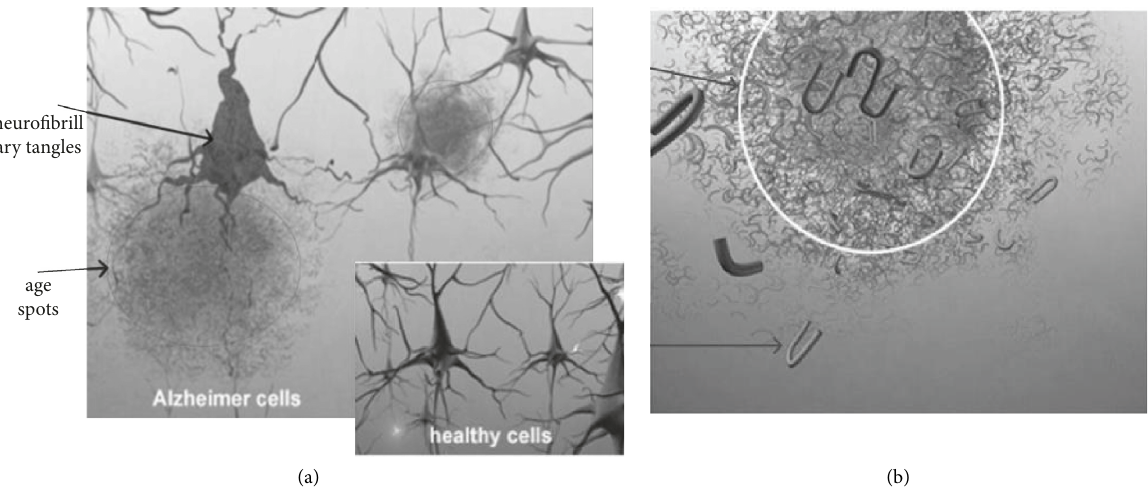
Figure 4: Schematic diagram of senile plaques and neurofibrillary tangles. (a) Schematic diagram of senile plaque. (b) Schematic diagram of neurofibrillary tangles.